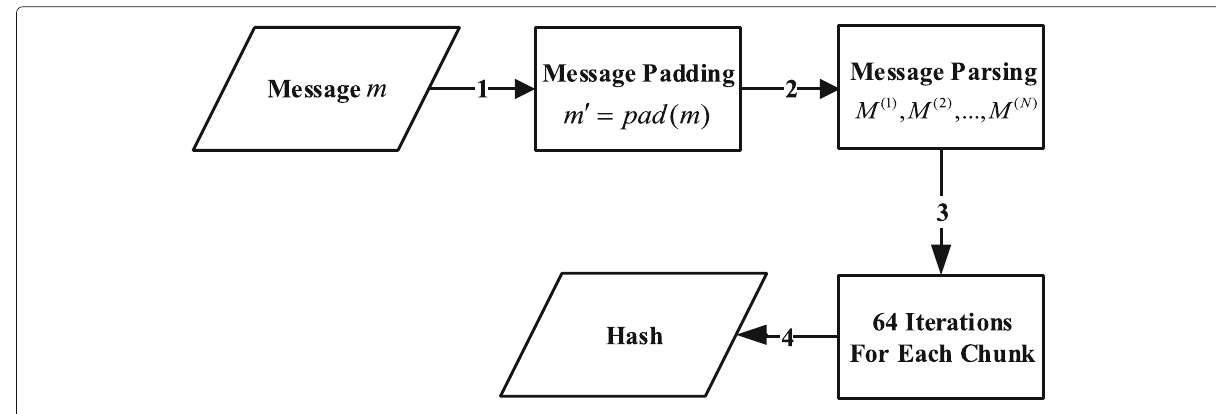
Fig. 5 Compute the hash value based on